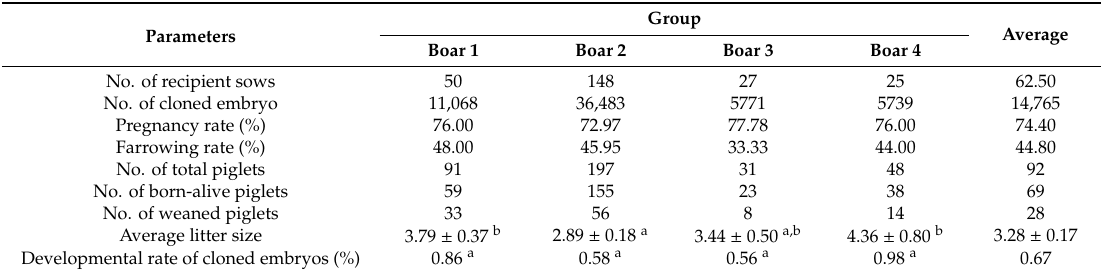
Table 1. Summary of the production of cloned Pietrain